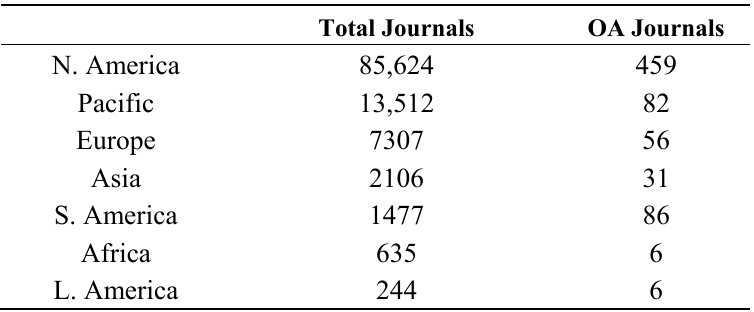
Table 1. Numbers of total journals and OA journals by continent (averaged by country in each continent)